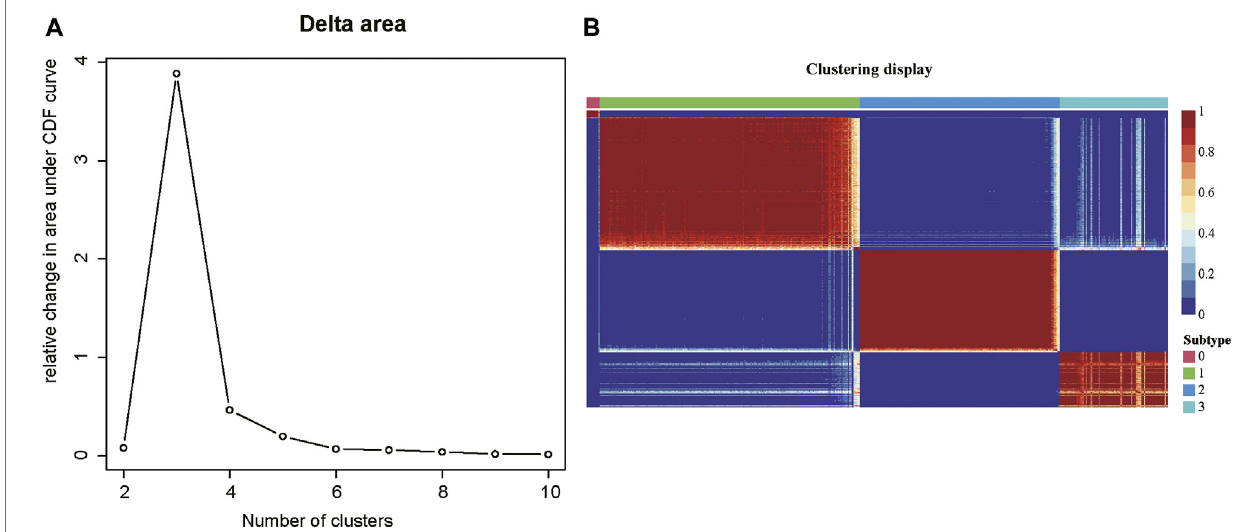
FIGURE 2 | The consensus clustering of the COAD patients by m6A-related lncRNAs. (A) The delta areas at cluster numbers from 2 to 10. (B) The sample-wise correlation matrix visualized in the heatmap.